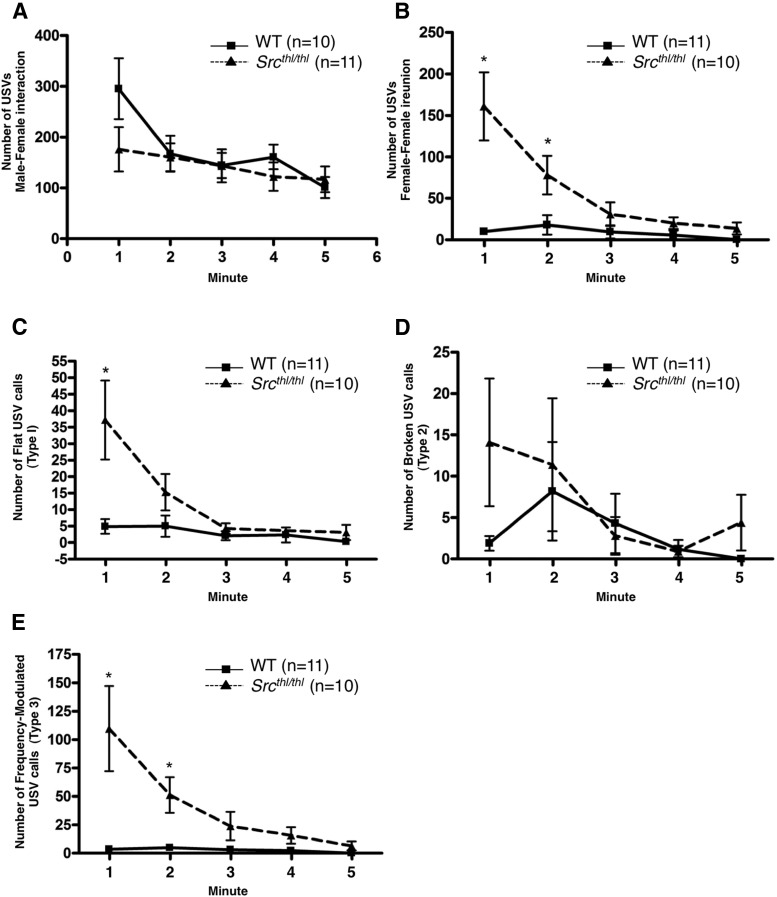
Enhanced social reunion of female Srcthl/thl mutant mice. A, Time course of total number of USVs in WT and Srcthl/thl male mice when introduced to females for a 5 min trial. A gradual decline in total number of calls was observed across time but the total number of calls was still high, with no significant difference between WT and Srcthl/thl mice. Data are presented as mean ± SEM for each time point (n = 10 WT, n = 11 Srcthl/thl). B, Time course of total number of USVs in WT and Srcthl/thl females when reunited with a litter mate for a 5 min trial. A gradual decline in total number of calls is observed across time with a significant difference between WT and Srcthl/thl females in total number of USVs produced in the first and second minutes (n = 11 WT, n = 10 Srcthl/thl). C, There is a significant difference in the number of flat (Type 1) USVs produced by WT versus Srcthl/thl females at minute 1 (n = 11 WT, n = 10 Srcthl/thl). D, There was no significant difference in the number of broken (Type 2) USVs produced by WT versus Srcthl/thl females across time (n = 11 WT, n = 10 Srcthl/thl). E, There is a significant difference in the number of frequency modulated (Type 3) USVs produced by WT versus Srcthl/thl females at minutes 1 and 2 (n = 11 WT, n = 10 Srcthl/thl). Data are presented as mean ± SEM for each time point. *p < 0.05 between genotypes.